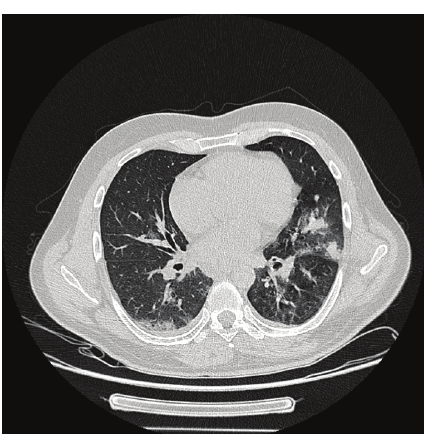
Figure 1: Computed tomography scan of the chest demonstrating diffuse bilateral opacities, mainly at the left